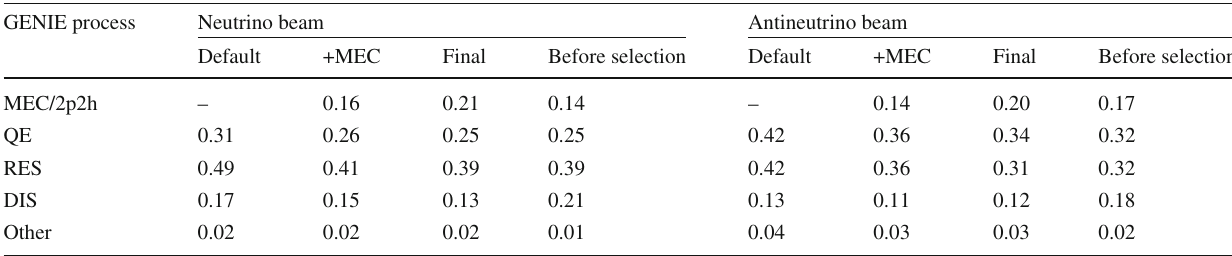
Table 1 Fraction of the predicted ν μ CC candidate sample correspond- ing to each GENIE major process in the default GENIE 2.12.2 con- figuration (“Default”), the default configuration with the addition of unadjusted Empirical MEC (“+MEC”), and after all the adjustments